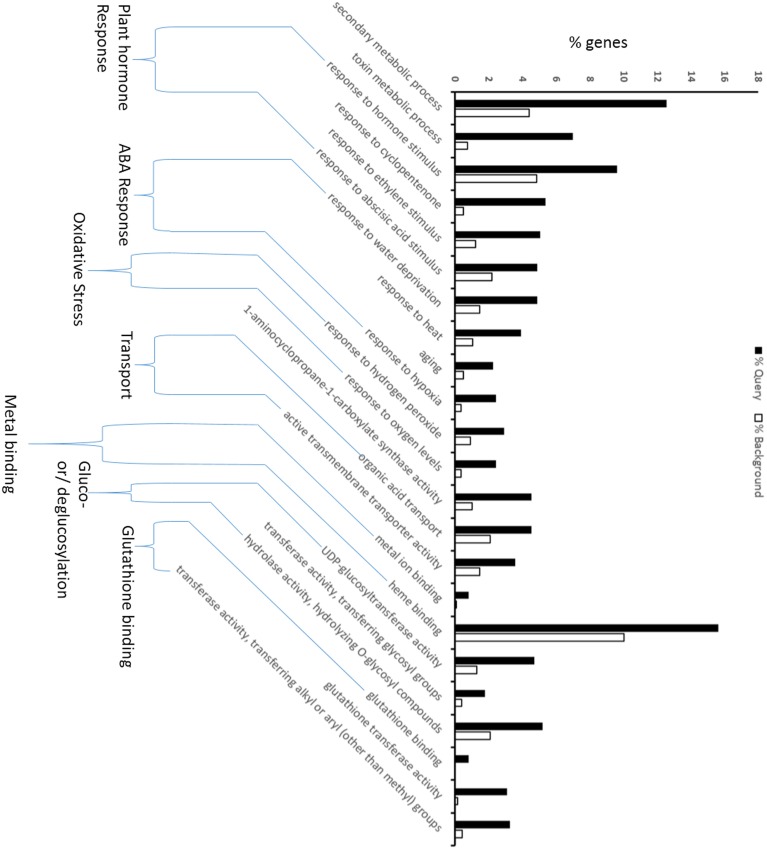
GO enrichment analysis for differentially regulated genes during gold treatment (AuCl−4). The analysis shows the ABA and Glutathione related processes were affected. The Singular Enrichment Analysis (SEA) of up- and downregulated genes with their GO IDs was performed using the agriGO analysis tool under customized mode, P < 0.05 and minimum 5 mapping entries. The black bar shows the fraction of query genes for particular GO term out of total no. of query genes, and the white bar provides the similar information with respect to genes present in background (whole genome). Please see details in Materials and Methods.